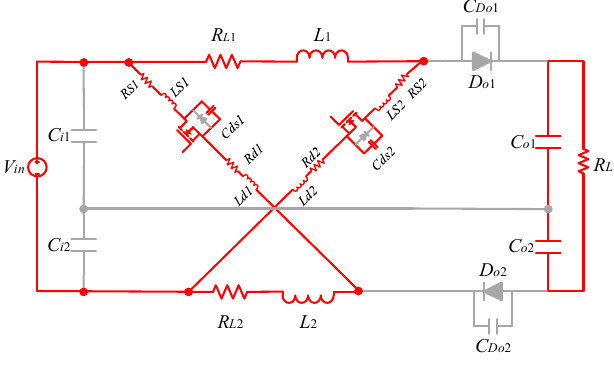
Figure 4. Equivalent circuit of Mode 1.